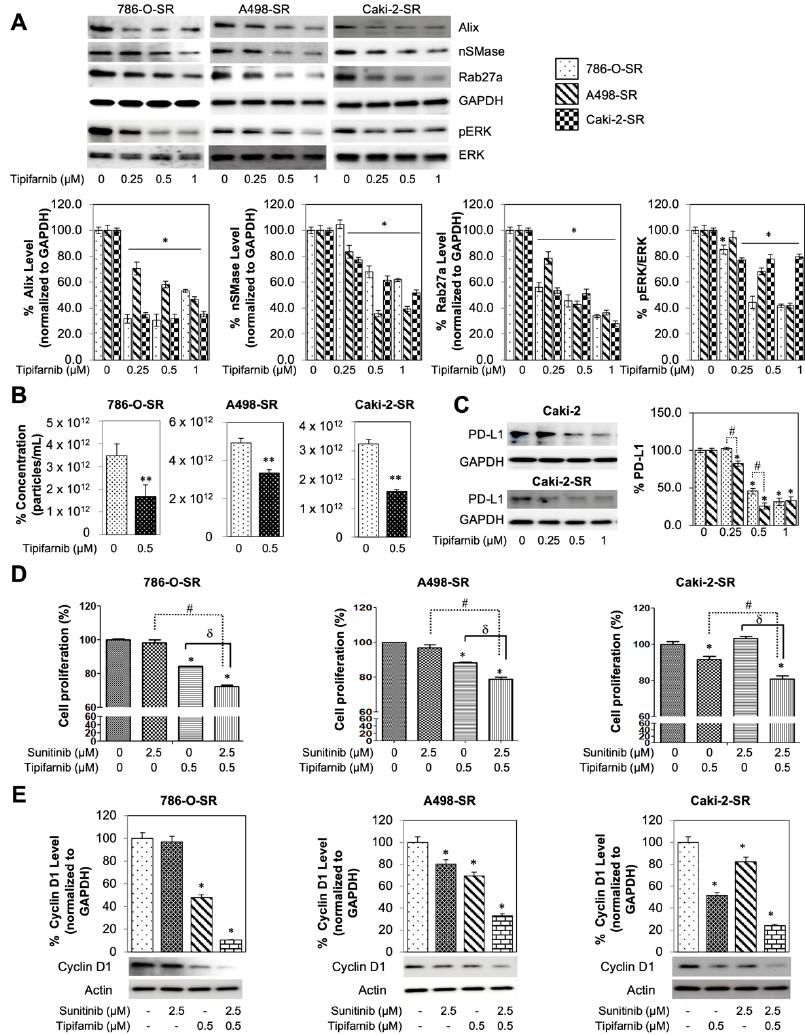
Figure 6. Sunitinib resistant cells response to tipifarnib and combination treatment. ( A ) Effect of tipifarnib co-exposure on SR RCC cells. Both ESCRT-dependent and -independent pathways are inhibited by tipifarnib but reduce the protein expression of Alix, nSMase, and Rab27a in a dose- dependent manner. Decrease in exosome specific biogenesis and secretion markers were seen for 786-O-SR, A498-SR, and Caki-2-SR cells. Full blots are presented in Supplementary Figure S8. ( B ) qNano-IZON particle quantitative analysis (NP-100 nanopore) after tipifarnib treatment, depicting a significant decrease in exosome concentrations (50 – 250 nm size) in the CM of 786-O-SR, A498-SR, and Caki-2-SR cell lines. ( C ) PD-L1 levels decrease after tipifarnib treatment in both Caki-2 and Caki- 2-SR cells. The densitometric plots show fold decrease in the expression of the signaling molecule. GAPDH immunoblot used as loading control was performed as previously described [21]. Full blots are presented in Supplementary Figure S8. ( D ) Anti-proliferative implications of the dual drug ther- apy on WST-8 assay. ( E ) Sunitinib and tipifarnib’s effect on cyclin D1 levels, normalized to GAPDH. Each assay throughout this figure was done in triplicate and the results were repeated at least in three independent batches of experiments. Representative results are shown, * p < 0.05, compared